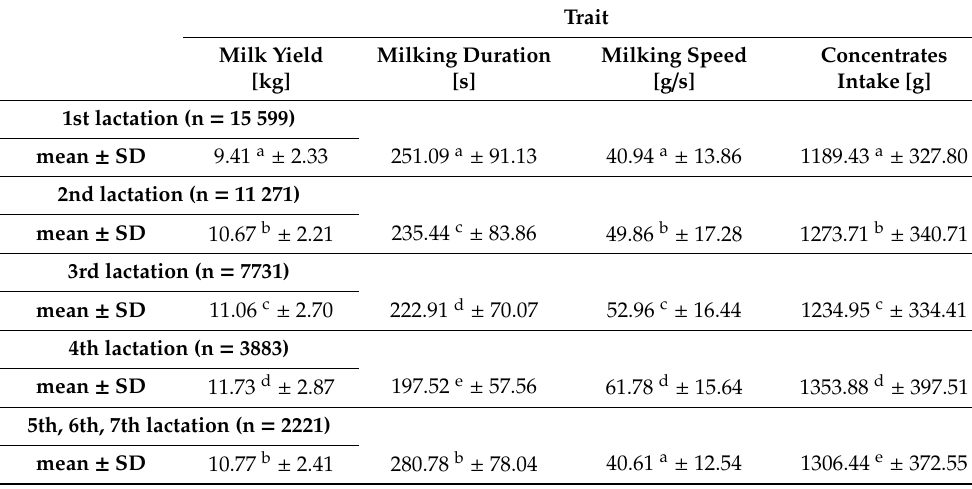
Table 5. Means and standard deviations (SD) of considered traits for single milking in the groups designated by lactation number.